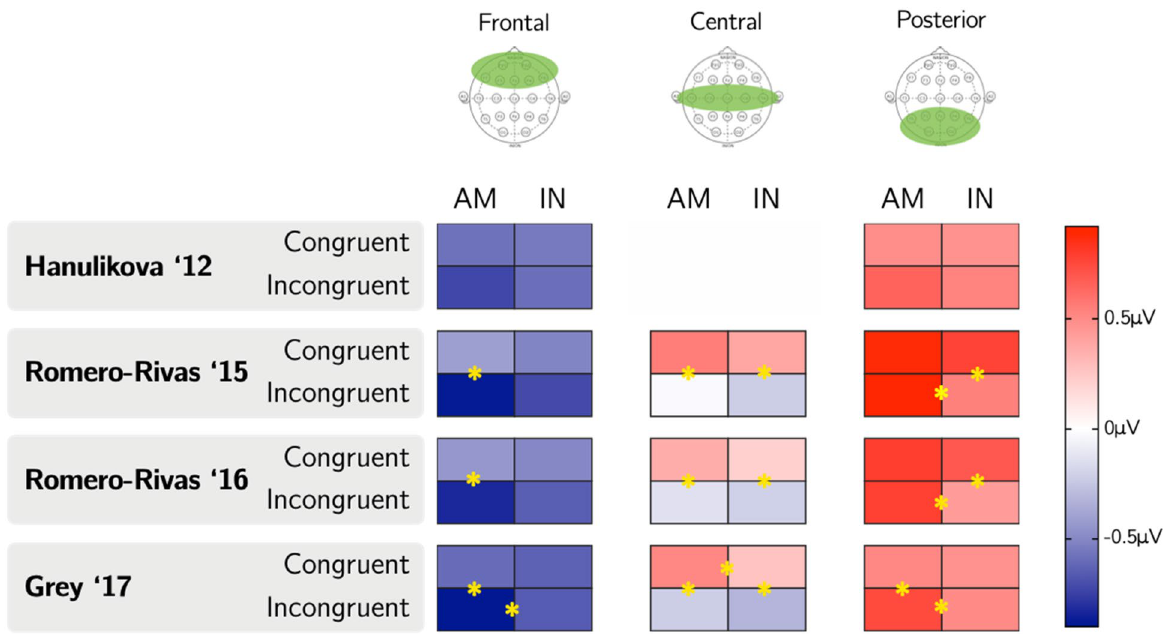
Figure 5. A graphical representation of average amplitudes in microvolts for each condition in the P600 time range for each parameter set, with a star on a line indicating a difference between conditions sharing that line significant at p <